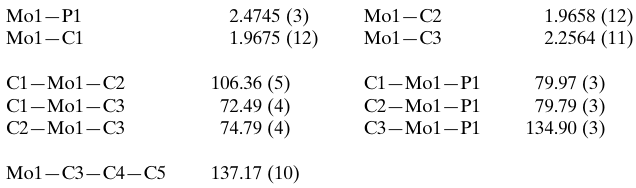
Table 3 Selected geometric parameters (A˚ , (cid:4) ) for ( 3 ).